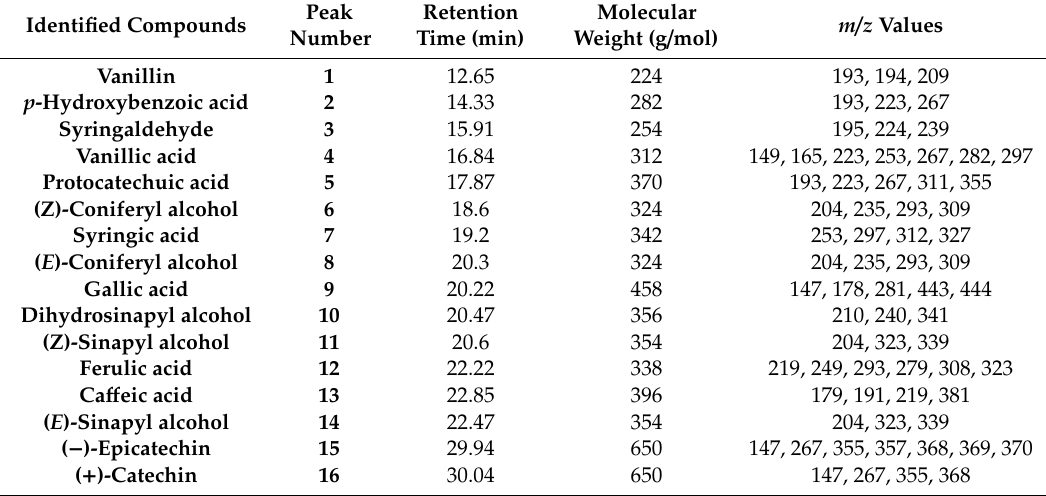
Table 1. Characteristics MS fragments of phenols as TMS